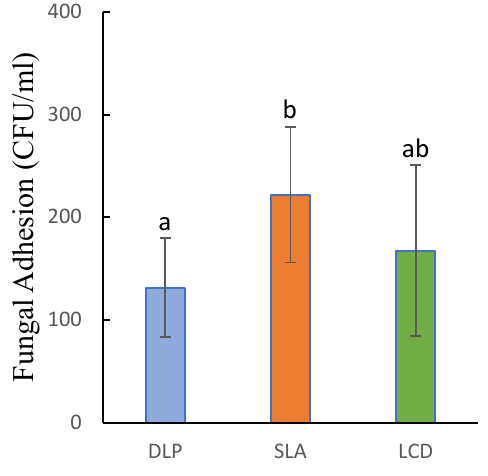
Figure 9. Adherence of Candida Albicans on 3D-printed denture base resin specimens. Similar letters indicate insignificant differences.